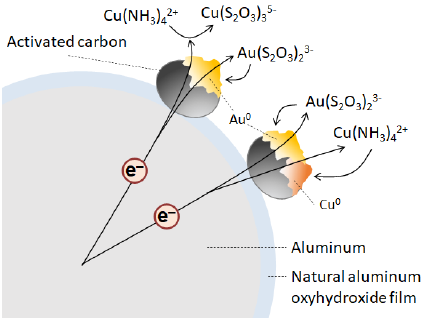
Figure 2. ( a ) Recovery of gold ions from ammonium thiosulfate solution with varying additions of Cu ions with concentrations from 0 to 50 mM, and SEM photomicrographs with corresponding el- emental maps of the residues at ( b ) 0 mM, ( c ) 10 mM, and ( d ) 50 mM of Cu ion additions.